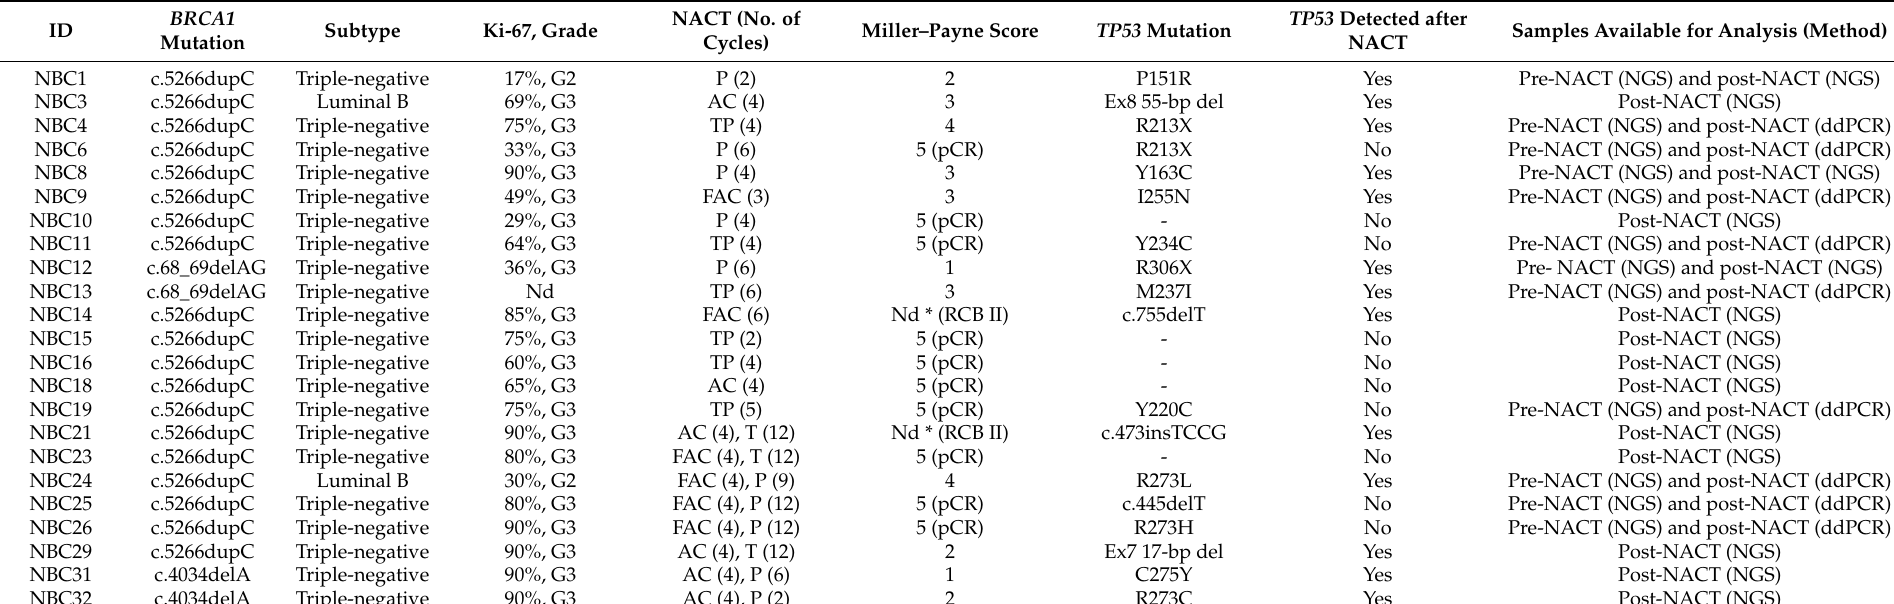
Table 3. Pathologic response according to Miller–Payne and TP53 mutations in residual